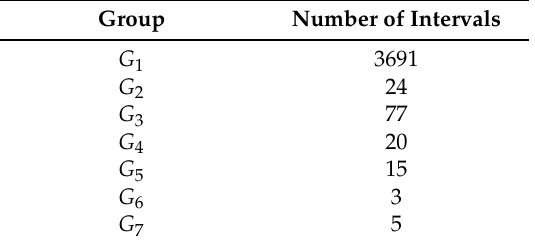
Table 3. Number of intervals per group using the UMED with L wH = 155 samples.